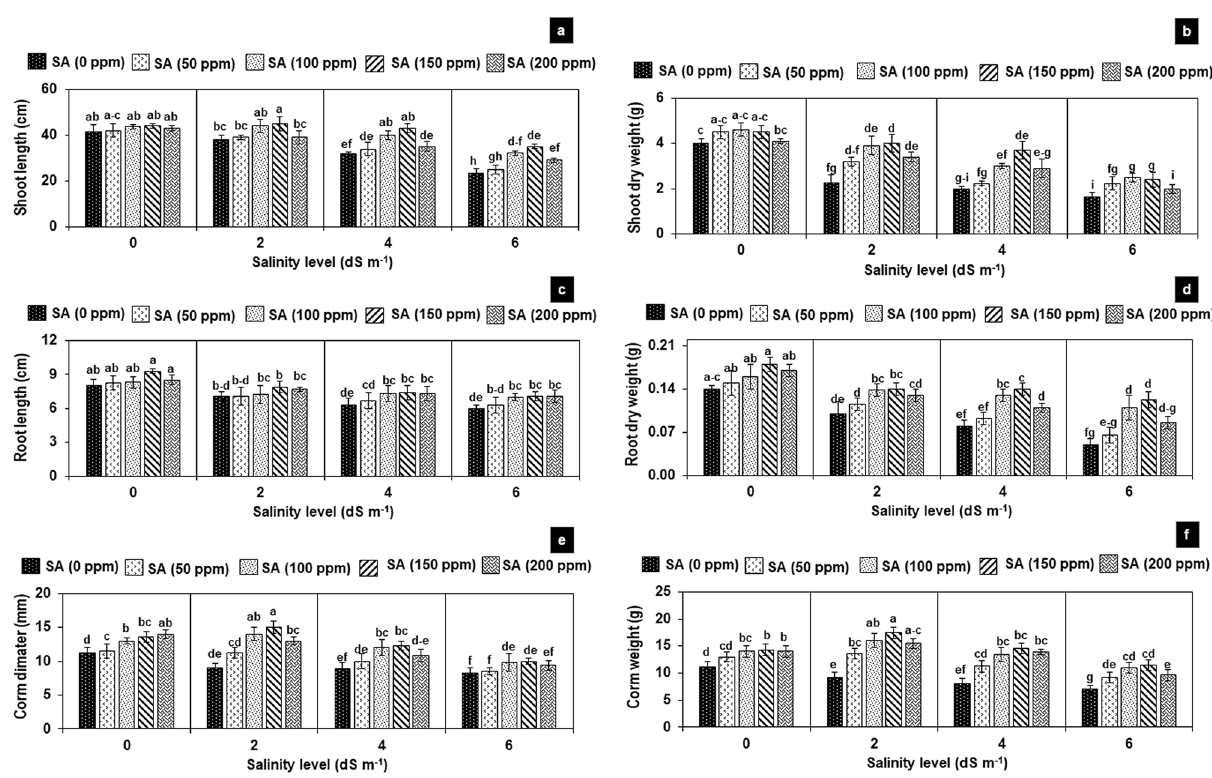
Figure 1. Effect of foliar application of salicylic acid on the growth attributes of Gladiolus grandiflorus under salinity stress 90 days after sowing . Vertical bars show starred error of mean of replicates. Different letters indicate significant differences (P < 0.05) according to LSD test; the same letter indicates no significant differences between the